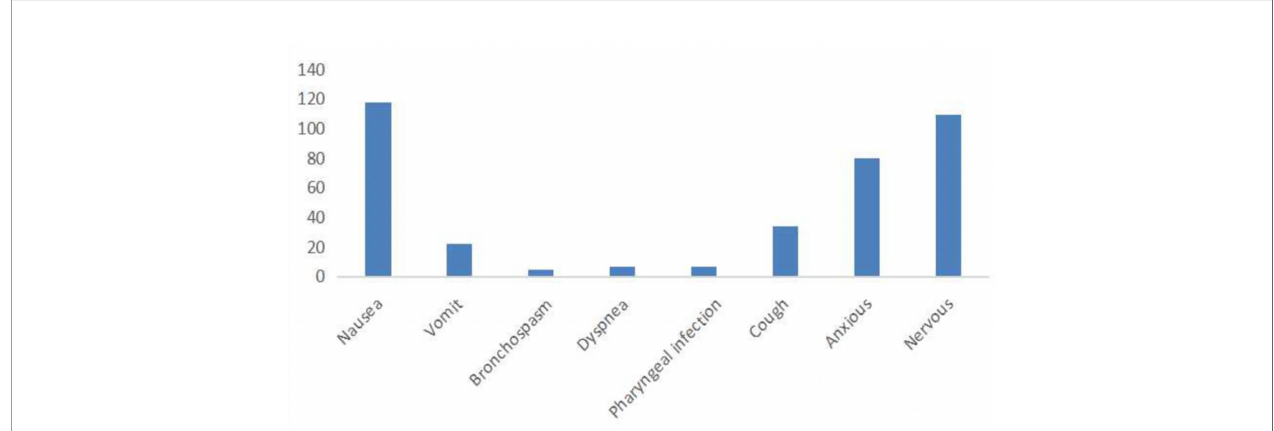
FIGURE 1 | Common adverse reactions in nucleic acid